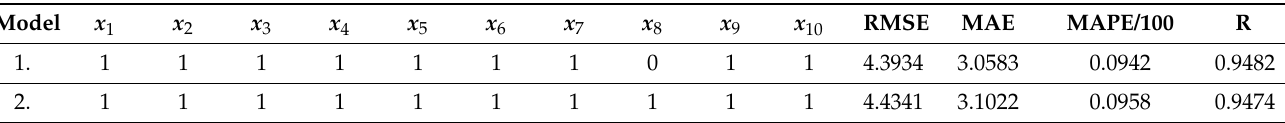
Table 10. Comparative analysis of GPR models with different sets of input